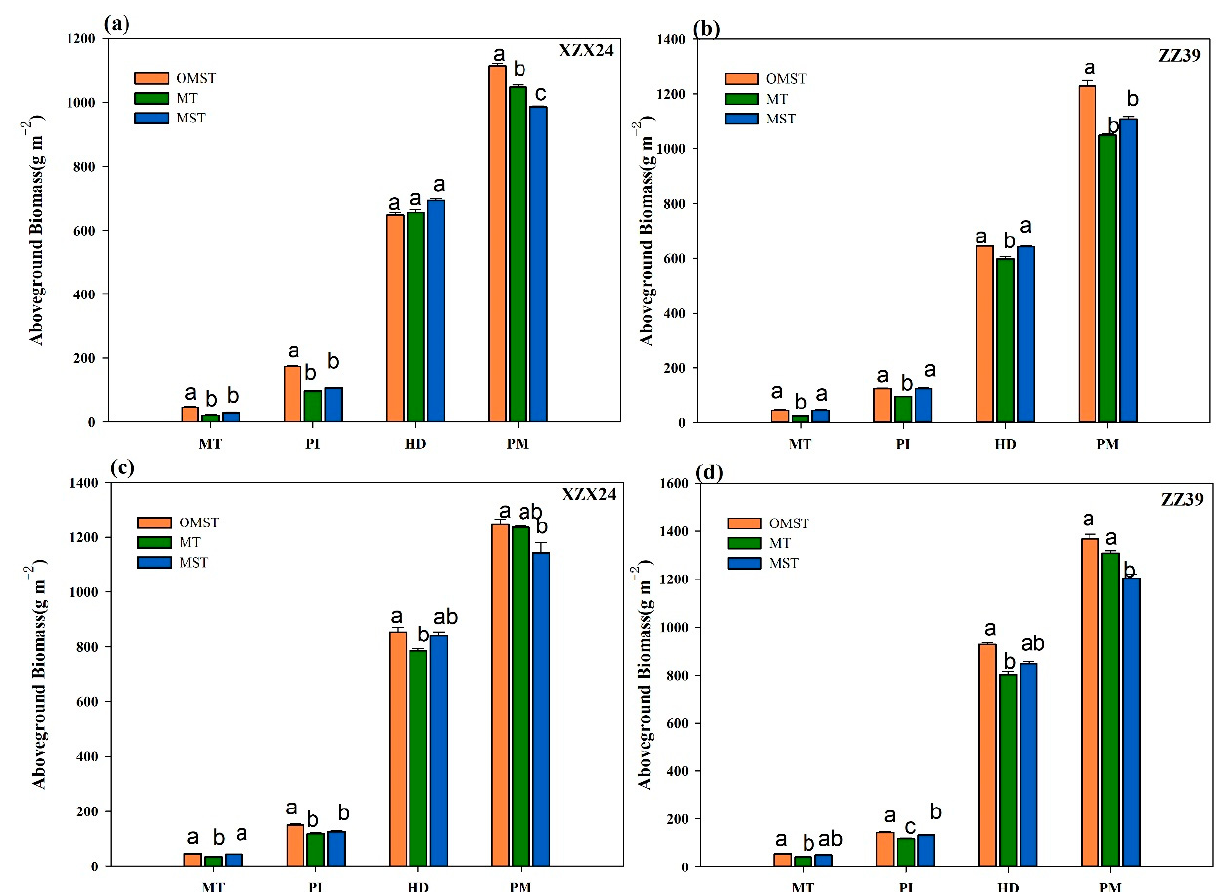
Figure 5. The aboveground biomass at different growth stages under different rice establishment methods: ( a )XZX24 in 2021 ,( b ) ZZ39 in 2021, ( c )XZX24 in 2022 , ( d ) ZZ39 in 2022.. OMST: Orderly mechanical seedling throwing, MT: Manual transplanting, MST: Manual seedling throwing, XZX24: Xiangzaoxian24, ZZ39: Zhongzao39, T: Middle tillering stage, PI: Panicle initiation stage, HD: Heading stage, PM: Physiological maturity stage. Different lowercase letters denote statistical differences among treatments of a cultivar at the 5% level according to LSD test. Error bars above mean indicate standard error ( n = 3).